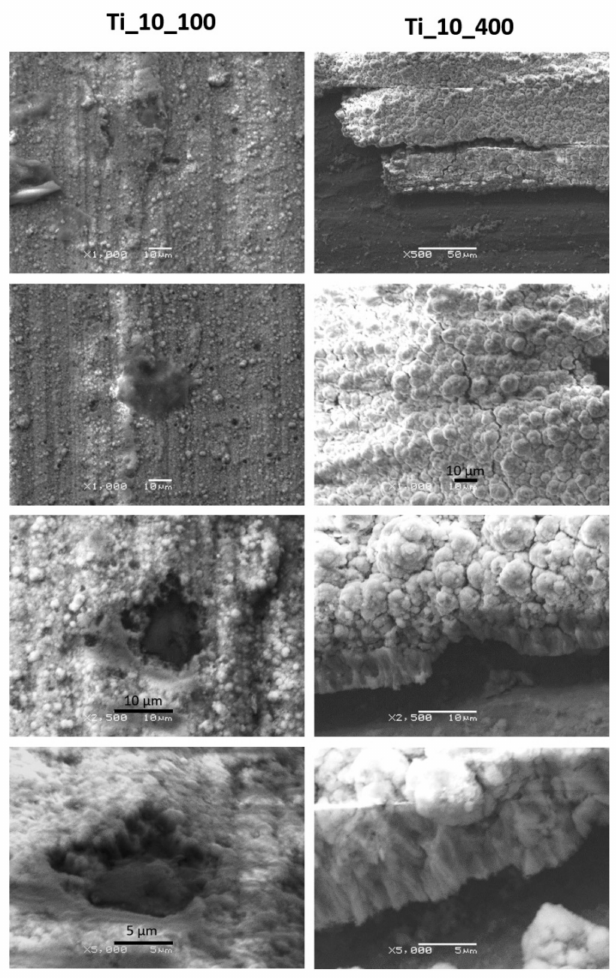
Figure 12. SEM micrograph of coating surfaces after corrosion resistance